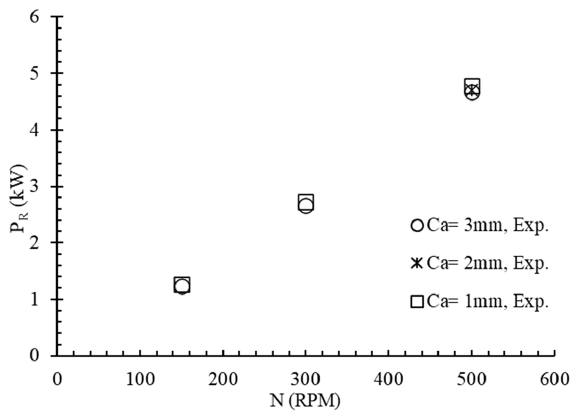
Figure 4. Result of experimentally obtained power